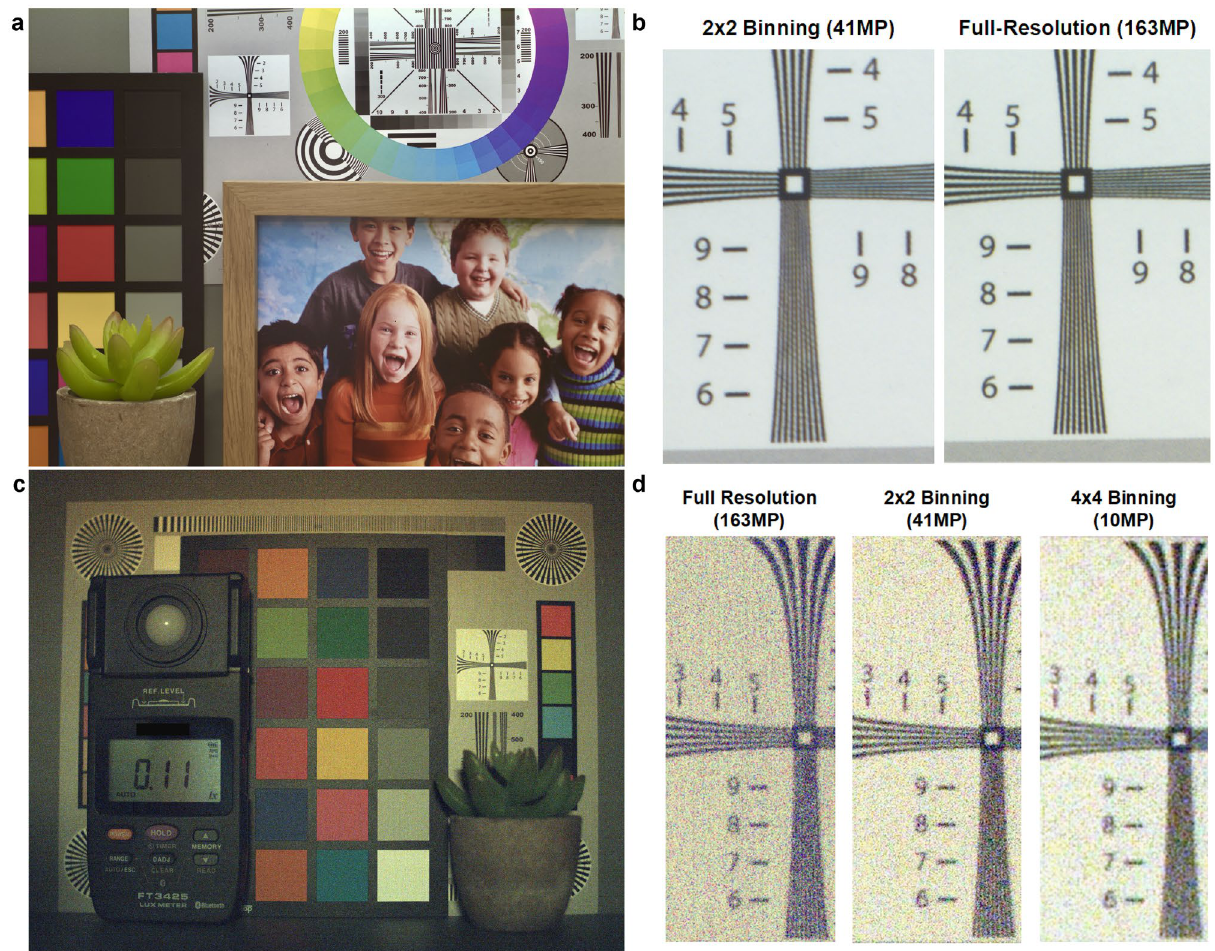
Figure 5. Sample images under office lighting condition (~ 400 lx) and ultra-low-light condition (110mlux). The high-light images were taken with F/4 lens and 40 ms exposure time, and the low-light images were taken with F/1.4 lens and 160 ms exposure time. ( a ) Full-resolution sample image under ~ 400 lx with demosaicing, white-balance, color correction matrix, and gamma correction applied. ( b ) Comparison of spatial resolution with 2 × 2 binning and full resolution. ( c ) 2 × 2 binning sample image under 110mlux with demosaicing, white- balance, color correction matrix, and gamma correction applied. ( d ) Comparison of spatial resolution with full resolution, 2 × 2 binning and 4 × 4 binning (2 × 2 charge binning + 2 × 2 digital